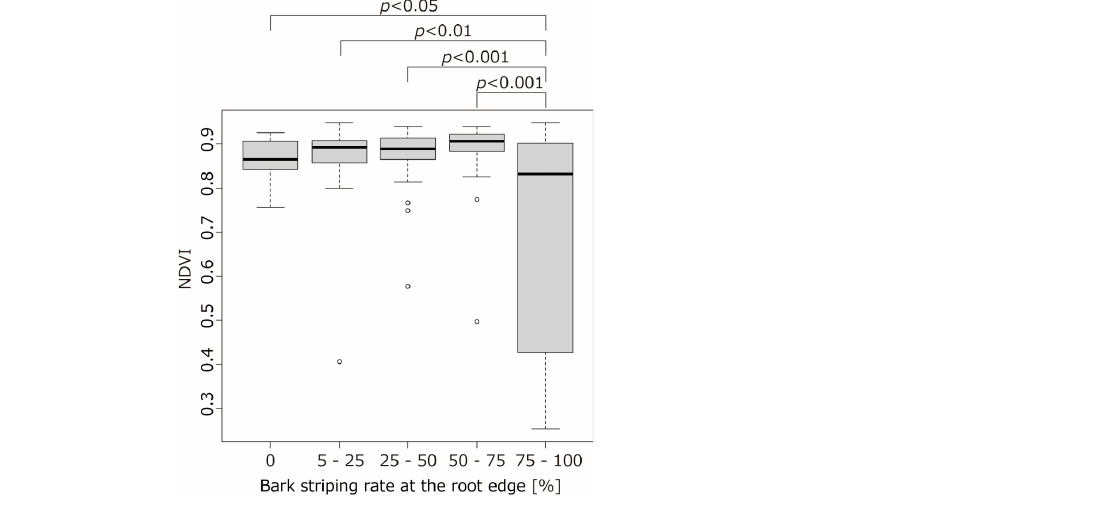
Figure 7. Relationship between the bark stripping rate at the root edge and the mean NDVI. Table 2. Relationship between growth conditions and bark stripping rate at root edge, classified by a threshold of 0.8.